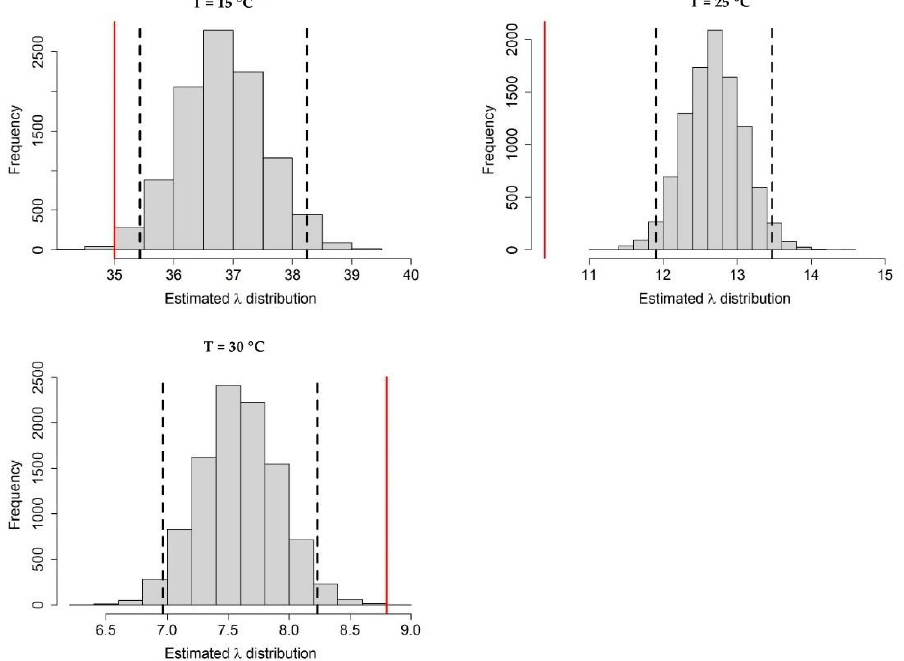
Figure A3. Estimated posterior distributions of Λ L1-A (T), the average duration (days) of development from L1 to A at 15, 25, and 30 °C. Dashed black lines represent the 2.5 and 97.5 quantiles. Solid red lines represent the average value for subtropical Ae. albopictus .